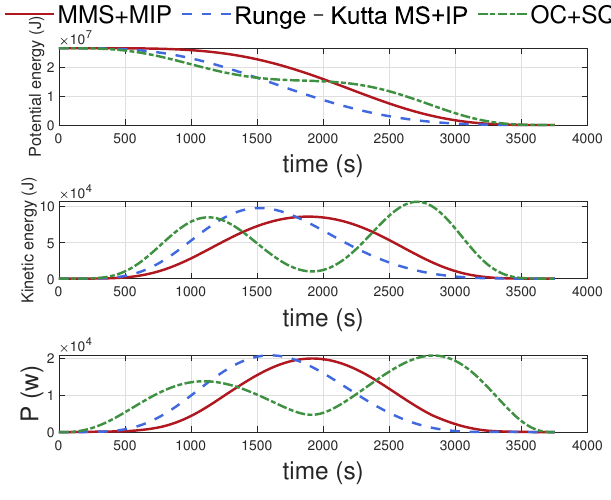
Figure 16. Energy and power changes between different